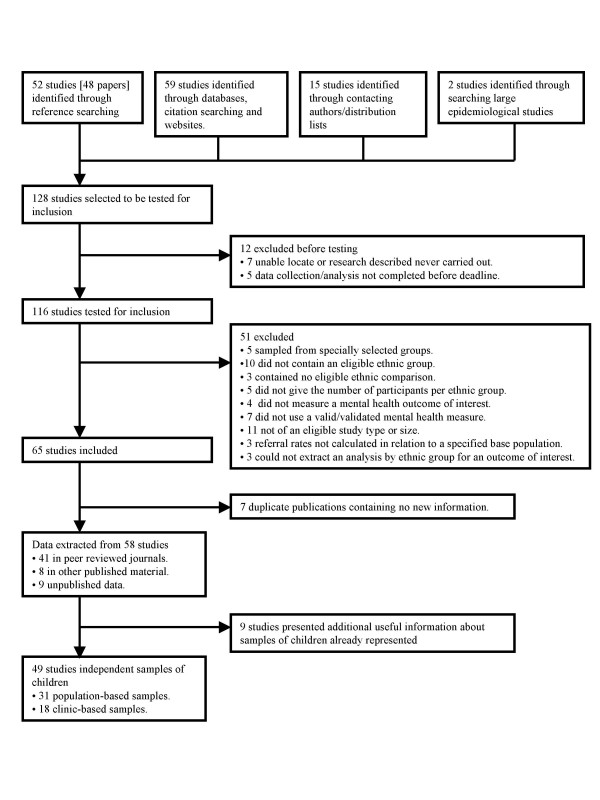
Selection of studies.